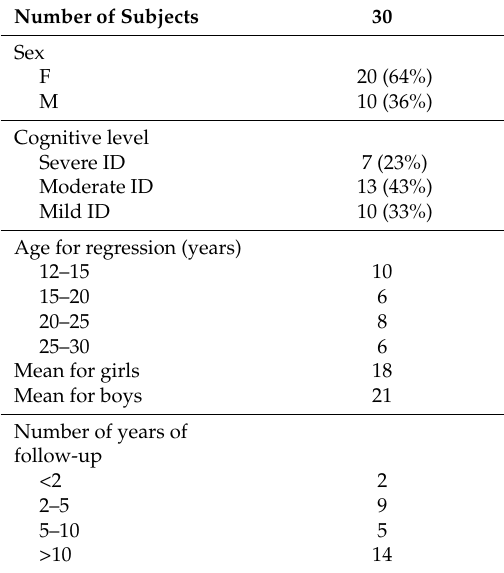
Table 1. Demography.